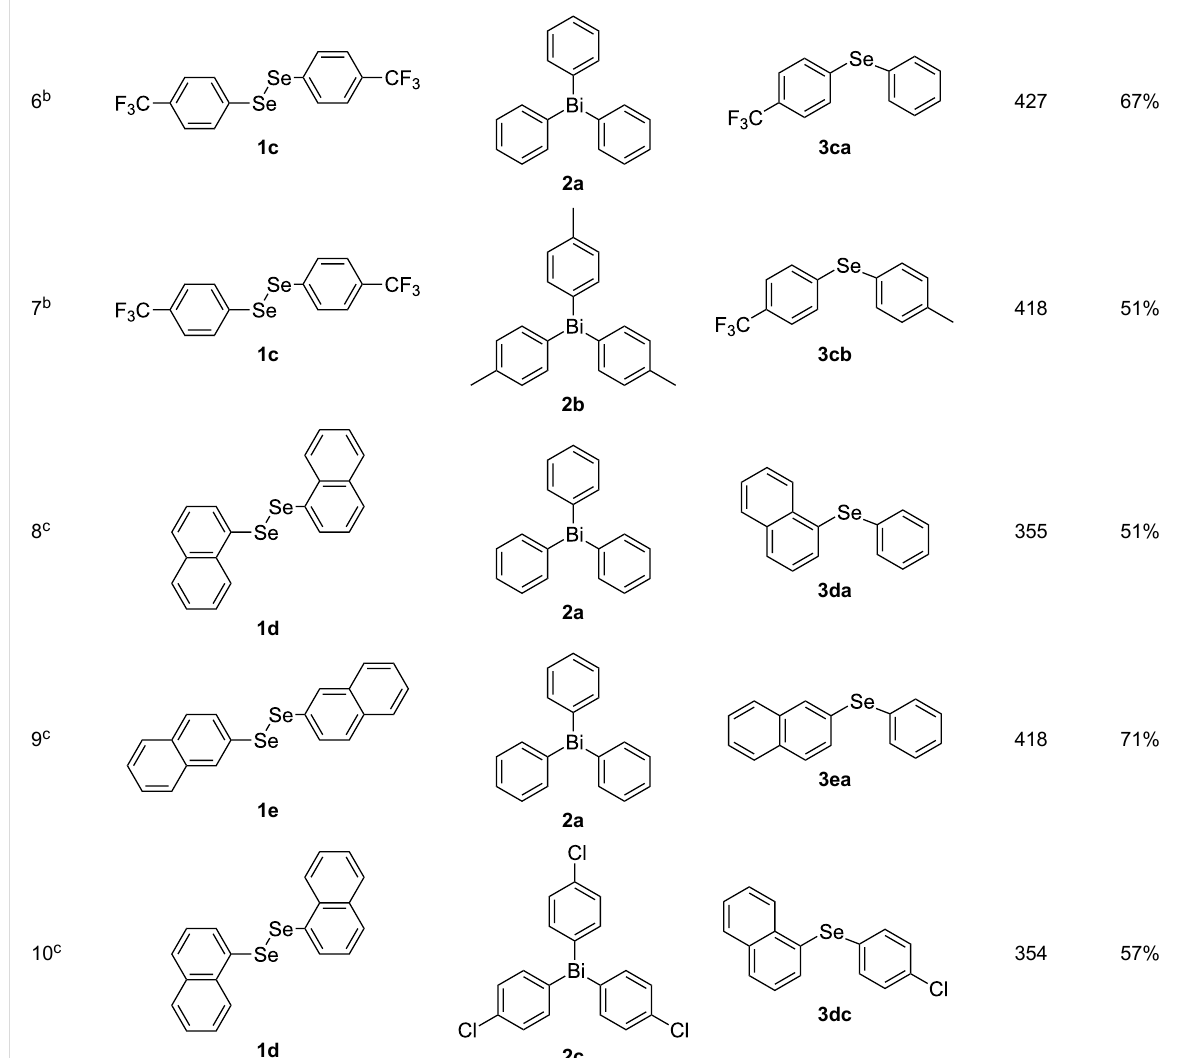
Table 2: Syntheses of unsymmetrical diaryl selenides. (continued)